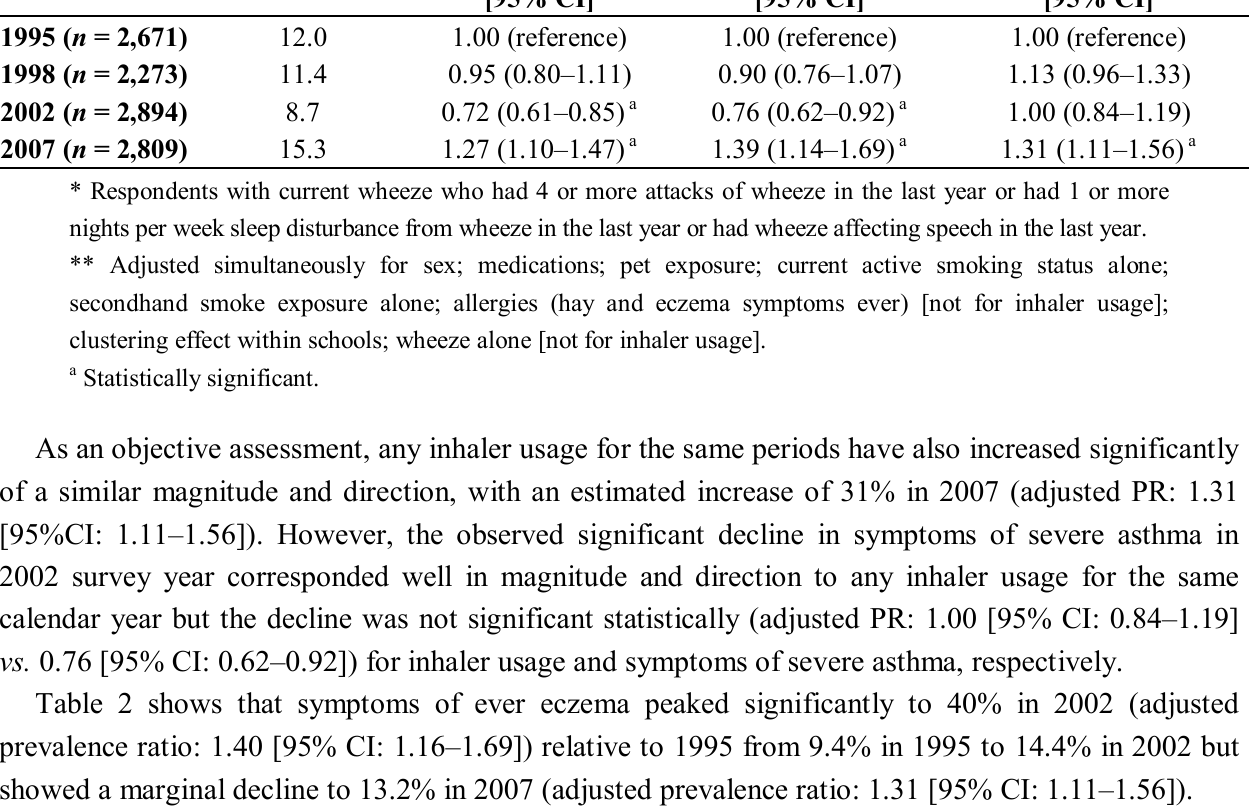
Table 1. Adjusted Prevalence Ratios (PR) of symptoms of severe asthma and inhaler usage among Irish school children aged 13–14 years, 1995–2007 ( n = 10,647). *Symptoms of Severe Asthma Prevalence Ratios (PR) Year Prevalence %